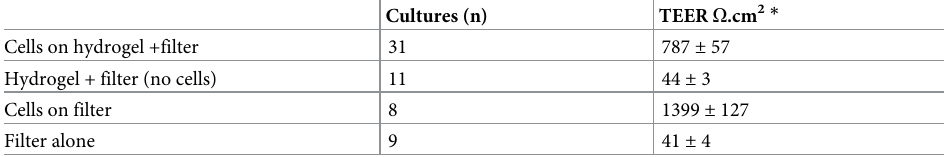
Table 2. TEER values of differentiated